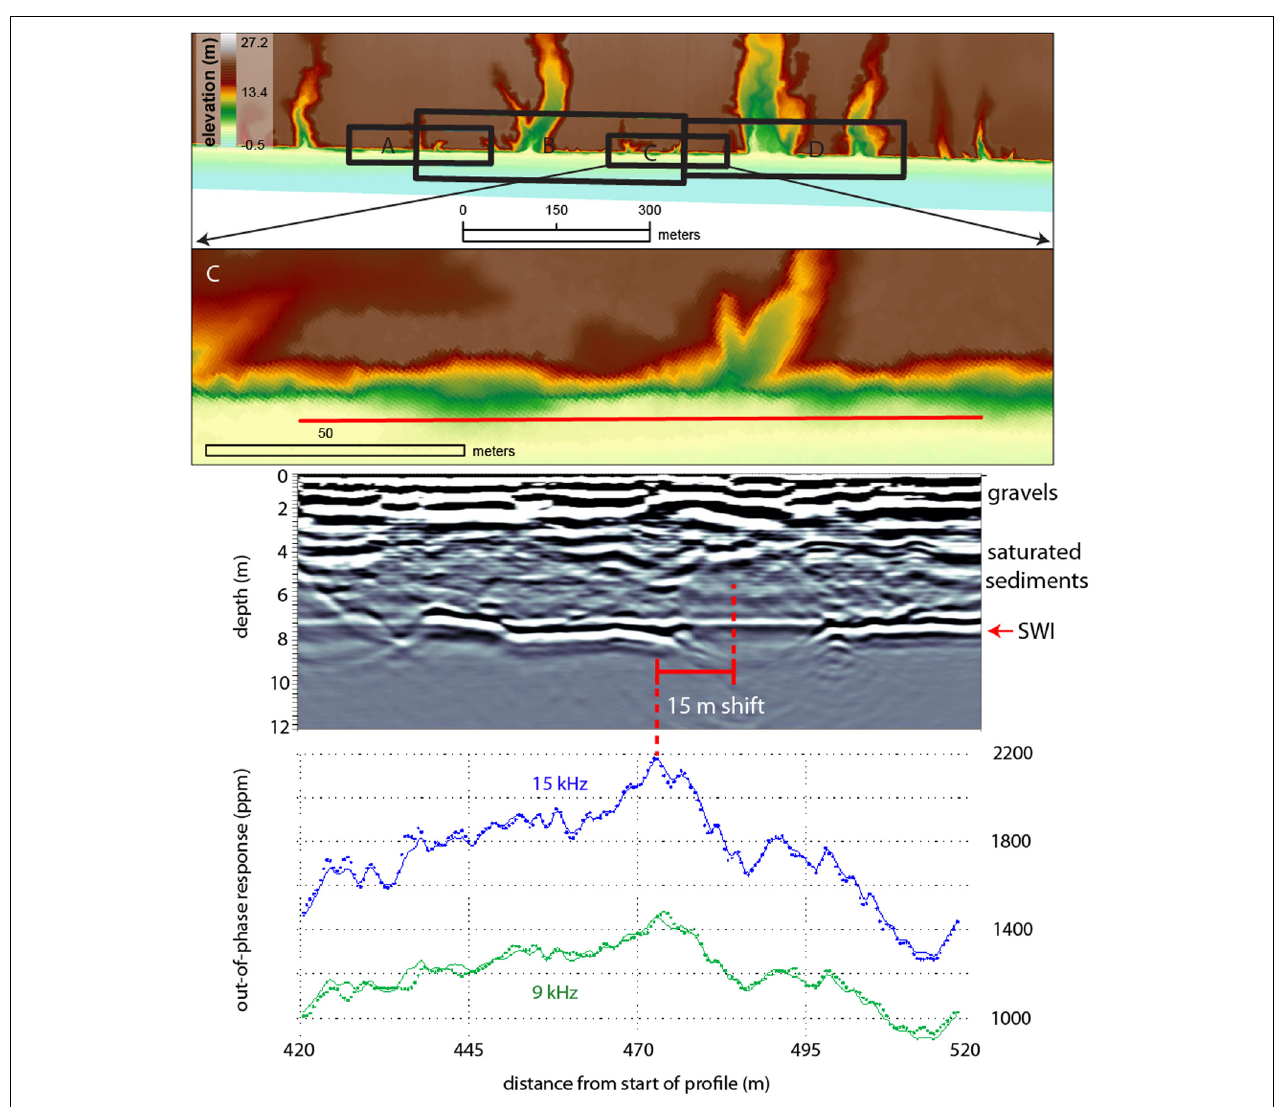
FIGURE 8 | Collocated GPR and EMI survey lines along profile